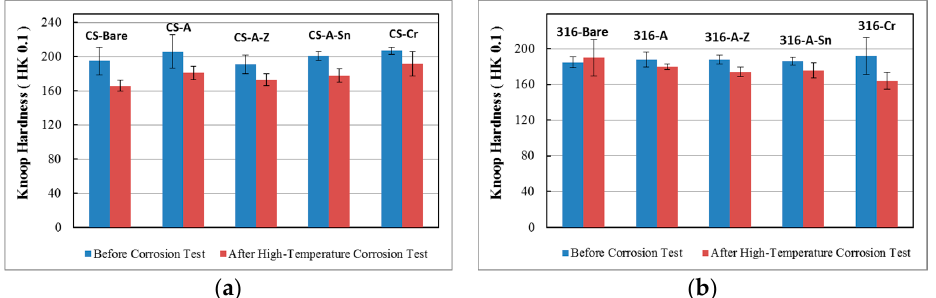
Figure 10. Comparison of Knoop hardness of the original substrate before and after the high-temperature corrosive attack for ( a ) low carbon steel, and ( b ) 316 stainless steel substrates.